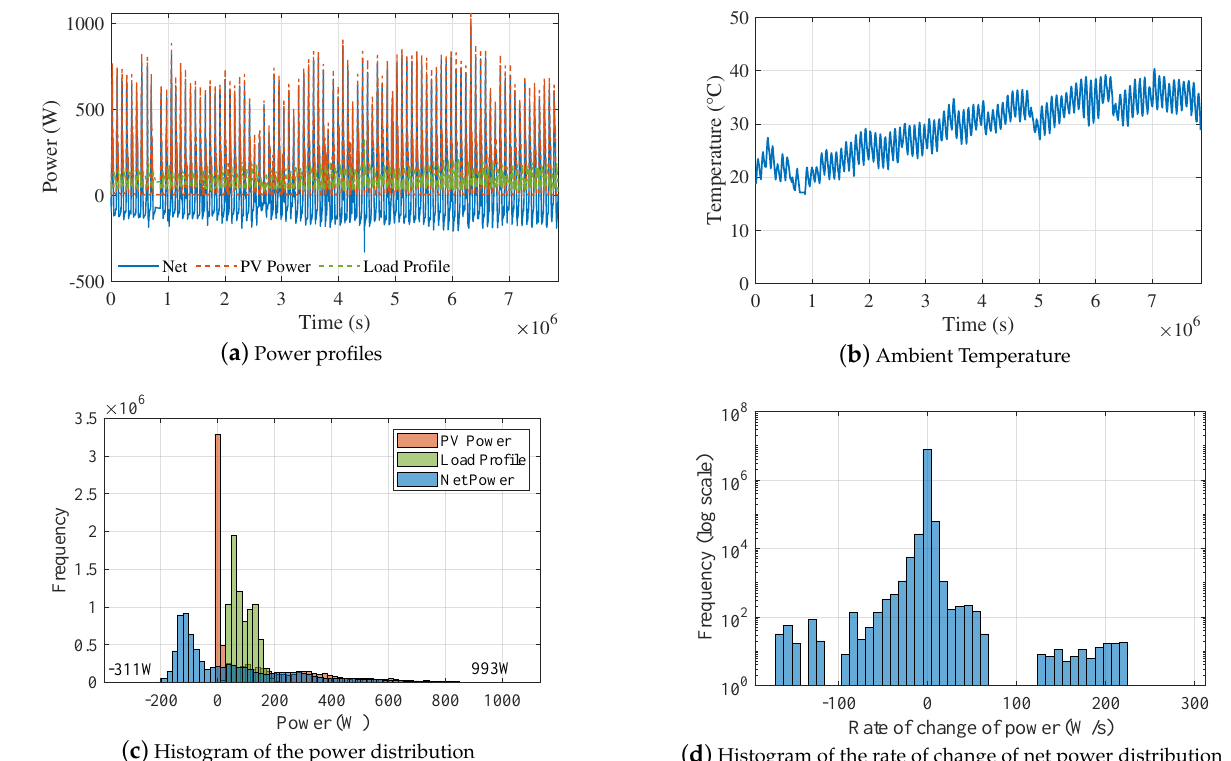
( d ) Histogram of the rate of change of net power distribution Figure 13. Ninety-day electricity and temperature profiles.